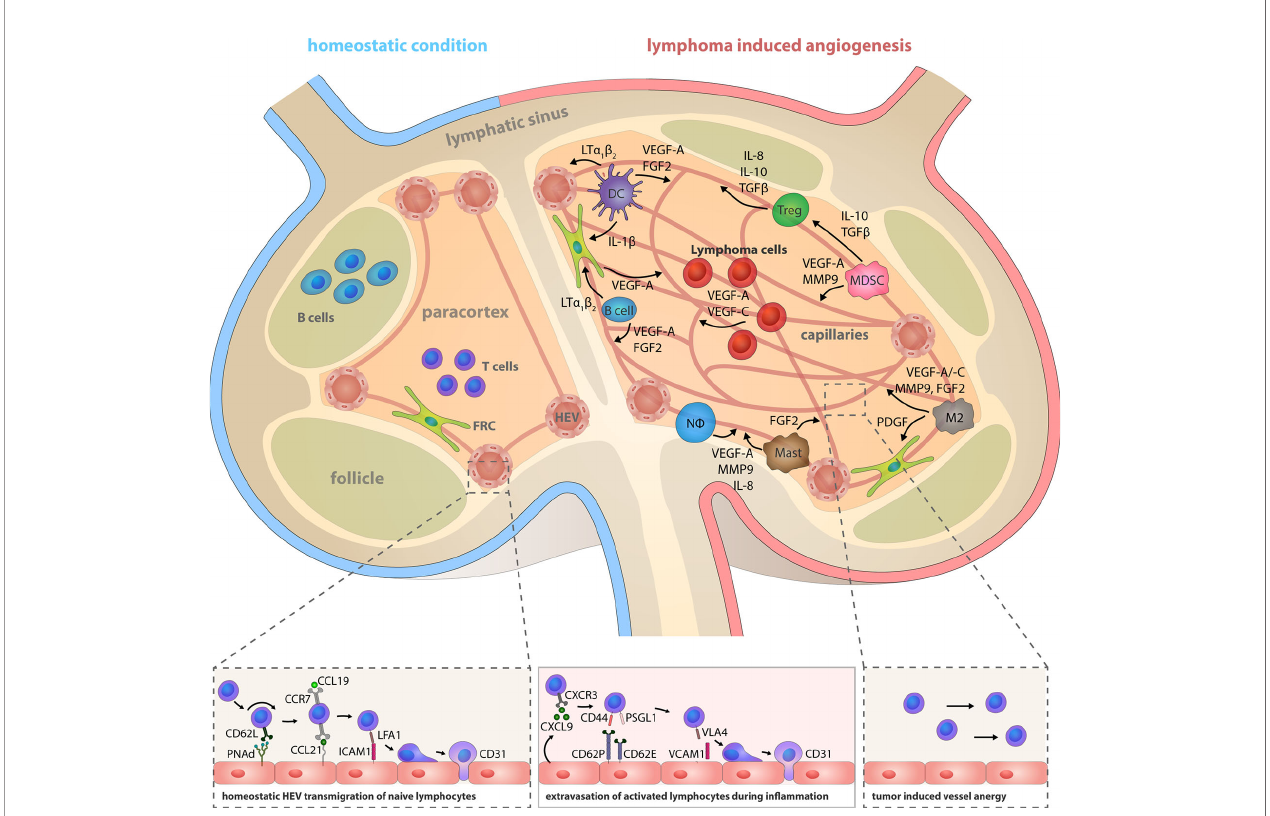
FIGURE 2 | Lymphoma induced angiogenesis in LNs and participating immune cells. Top: The LN compartments represented under homeostatic conditions (left) and lymphoma-activated angiogenesis (right). Lymphoma growth is characterized by a strong LN volume expansion and blood vasculature growth. Remodeling of the stromal infrastructure involves an increase of the microvessel density (MVD), as effectuated by direct angiogenic stimulation through lymphoma B cells cells, but concomitantly also through reciprocal crosstalk of cells in the TME and recruited immune cells. Notably, the initiation of the angiogenic switch in lymphoma is independent from hypoxia-induced HIF1 a pathway activation. Tumor polarized DCs (CEBP/ b high ) control the HEV differentiation status via LT a 1 b 2 and LIGHT presentation; they release IL-1 b and hereby take part in the blood vessel growth by inducing VEGF-A expression in FRCs. They also secrete the angiogenic factors VEGF-A and FGF2. B cells express LT a 1 b 2 , which exerts minor effects on HEVs, but a predominating stimulatory effect on FRCs. Expression of the chemokines CCL2, CXCL12, and MIF recruits additional immune cells into the LN. Regulatory T cells (Tregs), myeloid-derived suppressor cells (MDSCs), M2-polarized macrophages, neutrophils and mast cells are capable of producing the pro-angiogenic factors VEGF-A, VEGF-B, VEGF-C, MMP9, IL-8, IL-10, TGF b , and FGF1/2. Bottom left: HEVs express PNAd, CCL21, and ICAM1 and thereby constitute the transmigration routes for lymphocytes under homeostatic conditions. Interaction of CD62L, CCR7, and LFA-1 on naïve lymphocytes with these HEV-associated surface receptors and chemokines initiates lymphocyte rolling, HEV wall adhesion and eventually, transmigration into the LN parenchyma. Bottom middle: In fl ammatory vessels in reactive LNs recruit activated lymphocytes by CXCL9 secretion and replace the homeostatic receptors on endothelial cells with CD62P, CD63E, and VCAM1 that are interaction partners of leukocyte-expressed CD44, PSGL1, and VLA4. Bottom right: The lymphoma induced expansion of the blood vessel network favors the assembly of smaller anergic endothelium that is insuf fi ciently equipped for lymphocyte